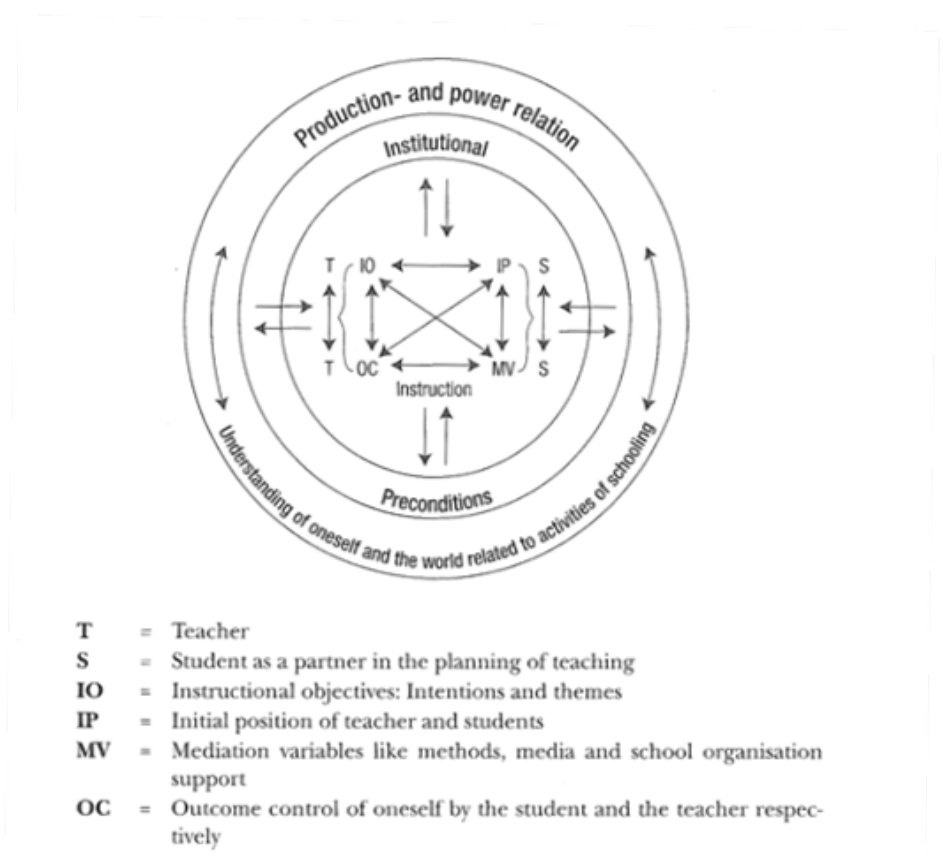
Figure 2 . Hamburg model (Schulz, 1997; translated by Gundem,